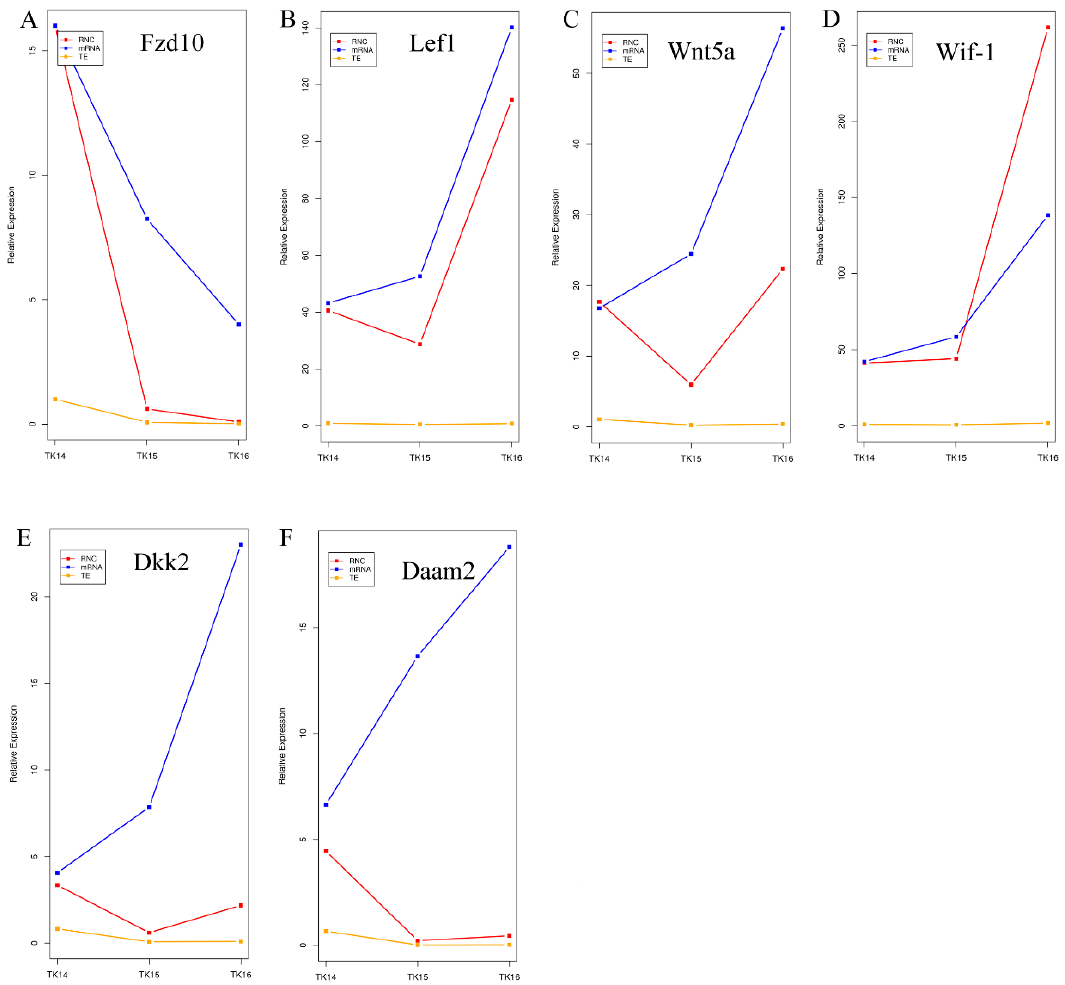
Figure 6. ( A – F ) Line plots of transcribed mRNA abundance, translated RNC-mRNA abundance, and translation rate of Fzd10 , Lef1 , Wnt5a , Wif-1 , Dkk2 and Daam2 in TK14, TK15, and TK16 CR tissues. The red line represents the translated RNC-mRNA abundance, the blue line represents the transcribed mRNA abundance, and the yellow line represents the translation rate.